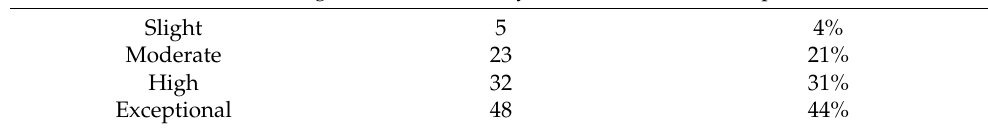
Nepal, Uganda, Nigeria, UAE, Brazil, and